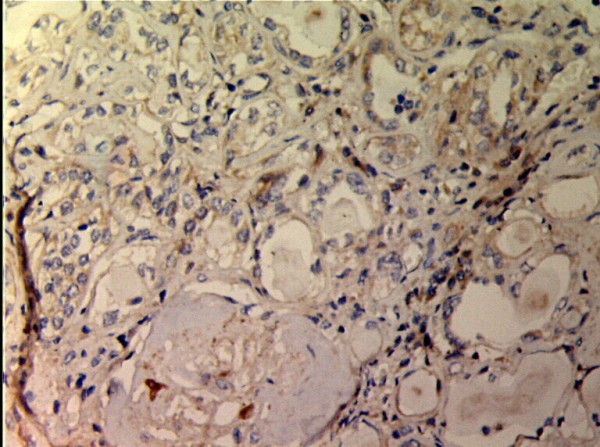
TIMP-1 expressions in renal tissue with different degree of interstitial fibrosis/tubular atrophy. (EnVision assay; original magnification × 200). IF/TA-III Group.